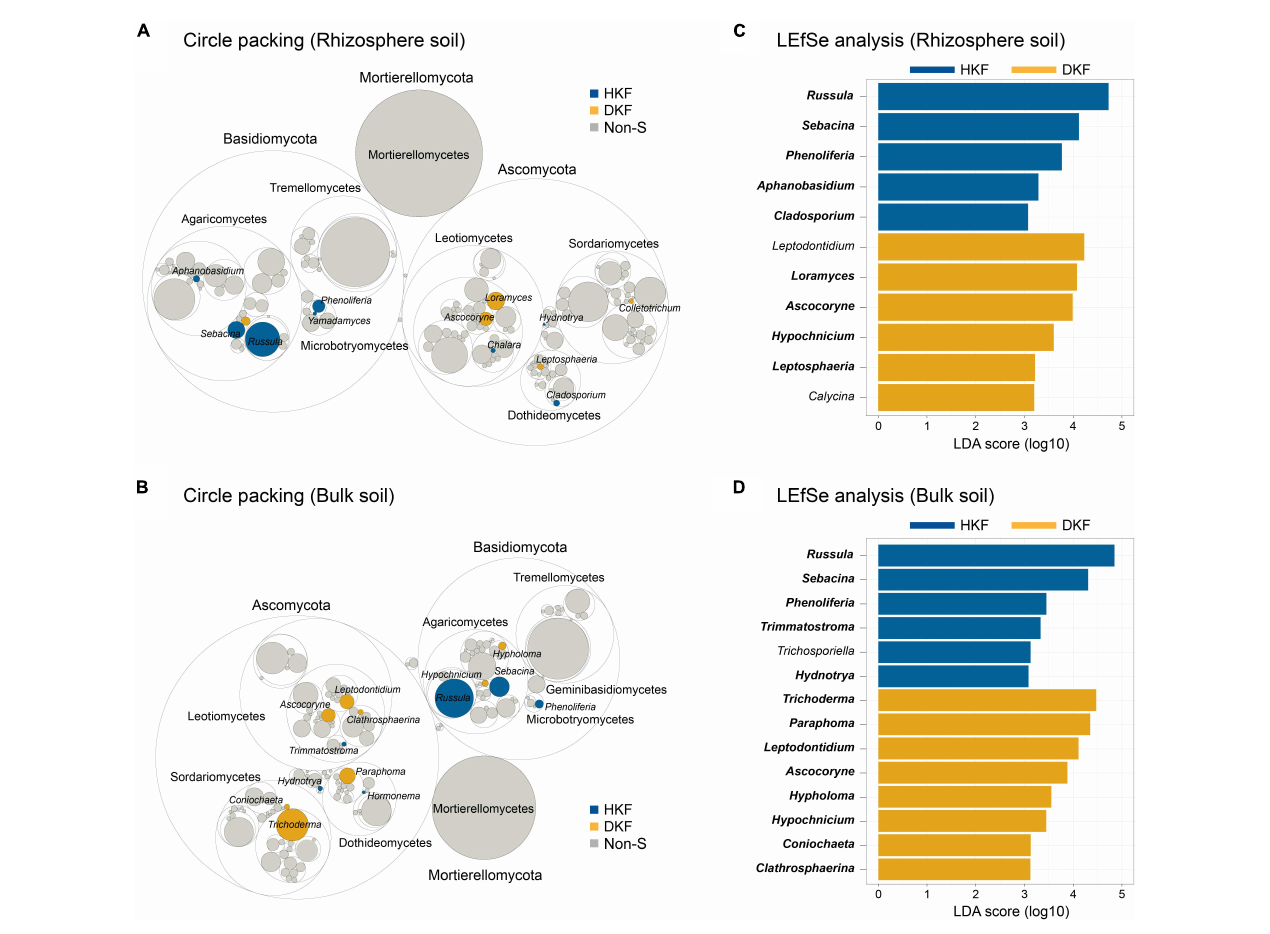
FIGURE3 Representative biomarkers at fungal genera level. The upper panel (A,C) is the analysis of the rhizospheric soil, and the lower panel (B,D) is the analysis of the bulk soil. (A,B) Circle packing plots represent the relative abundance of fungal genera observed in the healthy Korean fir (HKF) and dead Korean fir (DKF) groups. The statistically significant abundance of fungal genus for each group is indicated by HKF (blue) and DKF (yellow), and non-S (gray) when a significant difference was not met. (C,D) Linear discriminant analysis effect size analysis based on LDA score to detect biomarkers indicating differences between the groups (with LDA score >